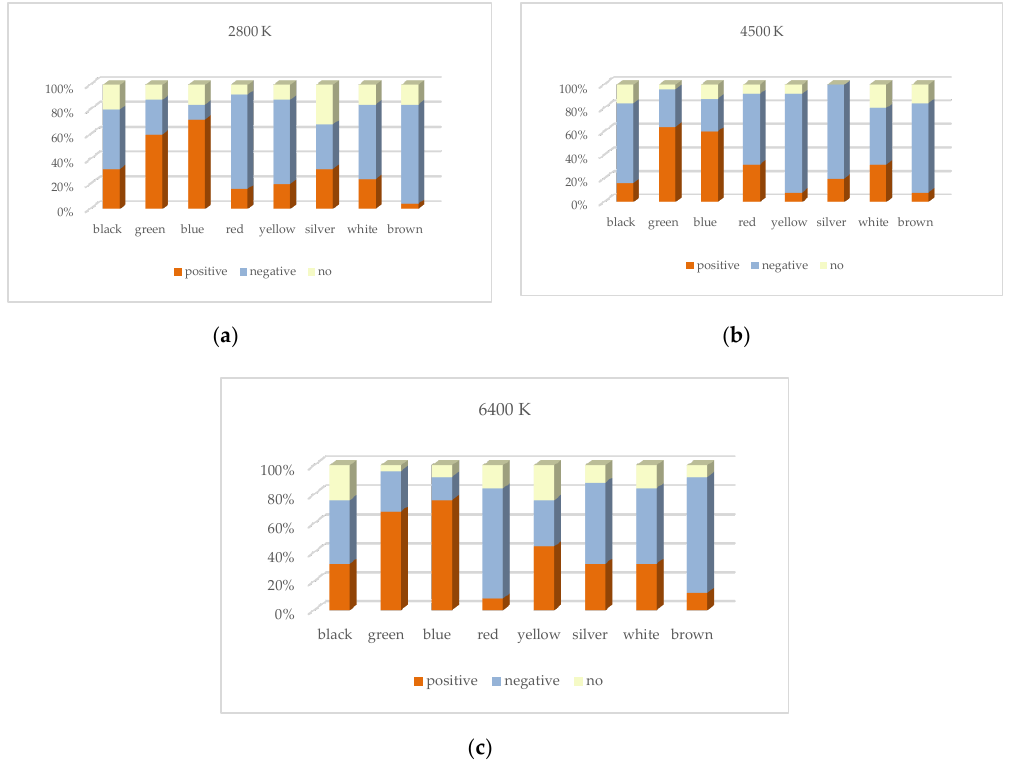
Figure 14. The probability distribution of the correlation between CRI2012 and reaction time when HP-CCT is 3000 K. ( a ) LP-CCT = 2800 K. ( b ) LP-CCT = 4500 K. ( c ) LP-CCT = 6400 K.